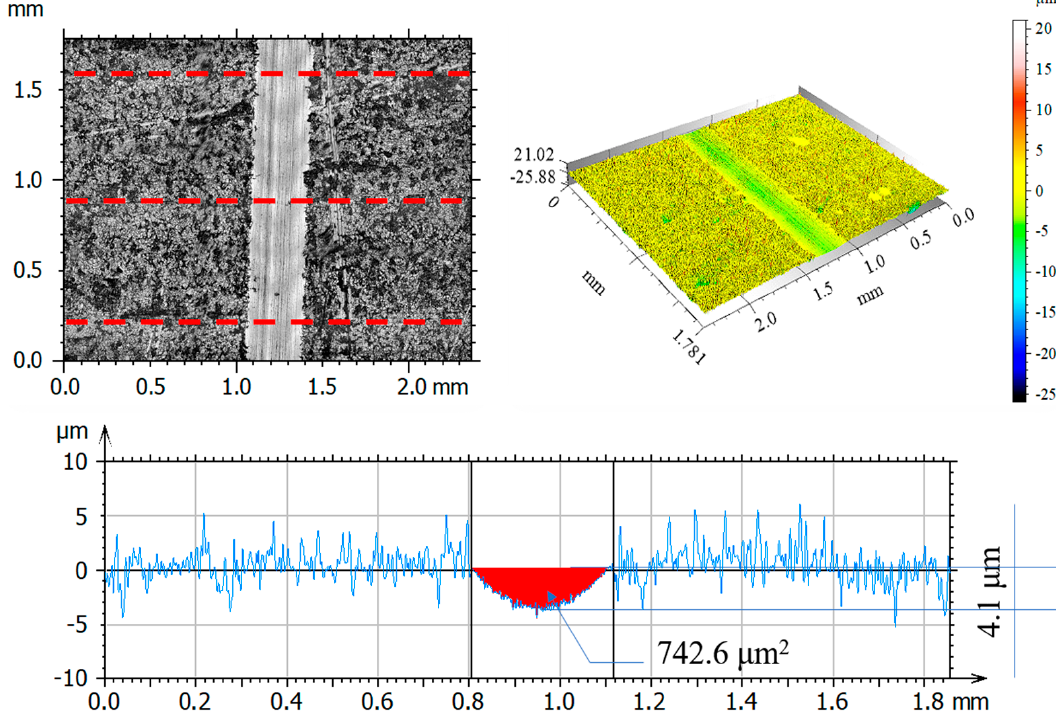
Figure 14. Optical and axonometric views of sample wear track and the wear profile on transverse cross-section after the RS-lubricated sliding of the steel 316L—Al 2 O 3 friction pair.